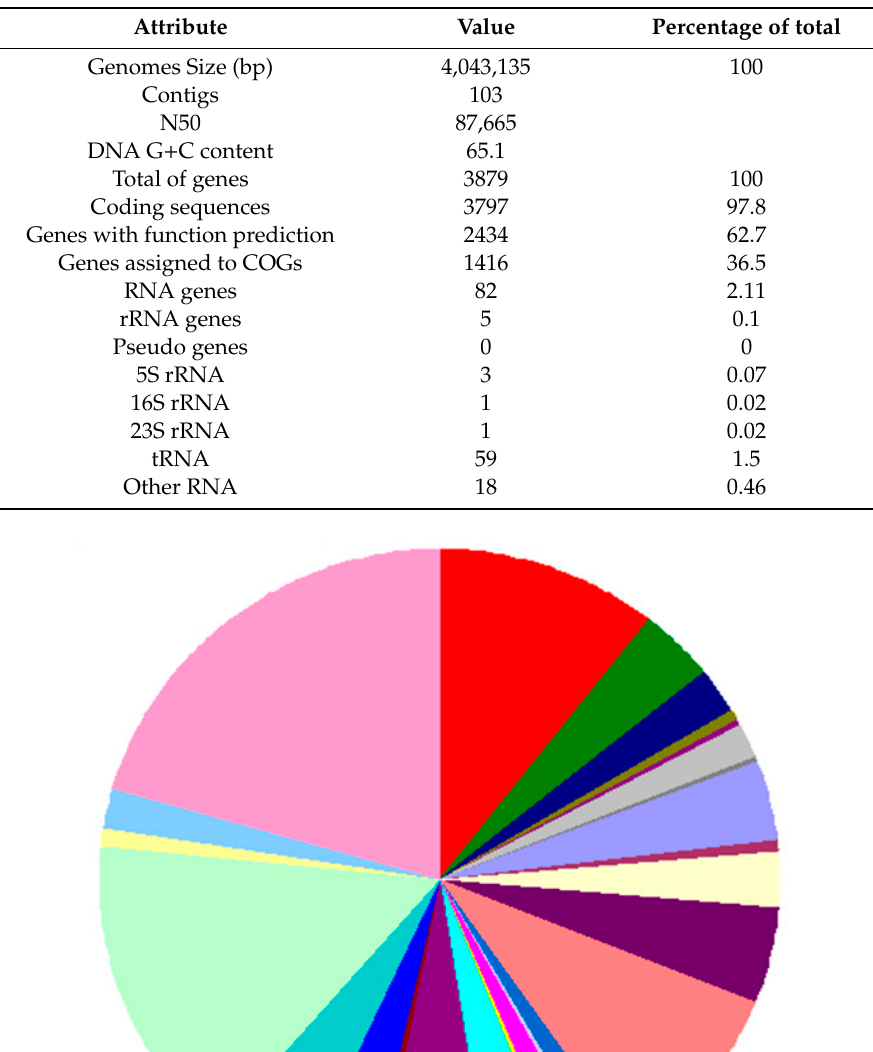
Table 1. Genome statistics according to Prokka annotation.